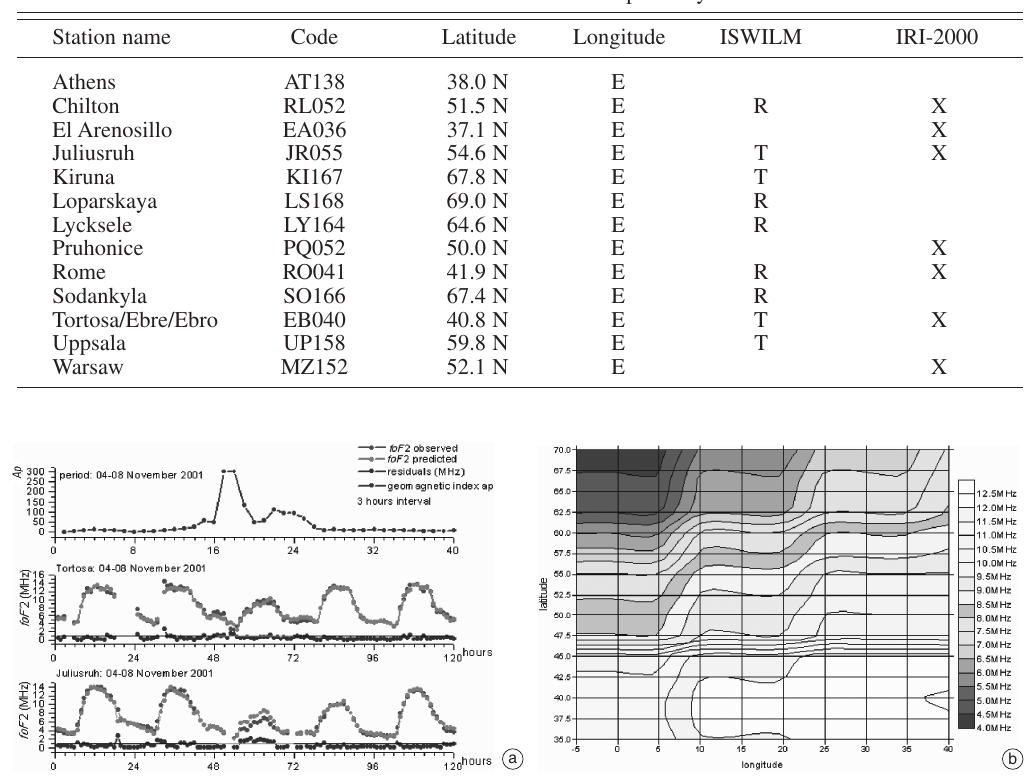
Table 3.I. Ionosonde stations. The ISWILM and IRI-2000 columns indicate the use made of data from the sta- tions in the studies described in Sections 3.4.1.1.2 and 3.4.1.2.1